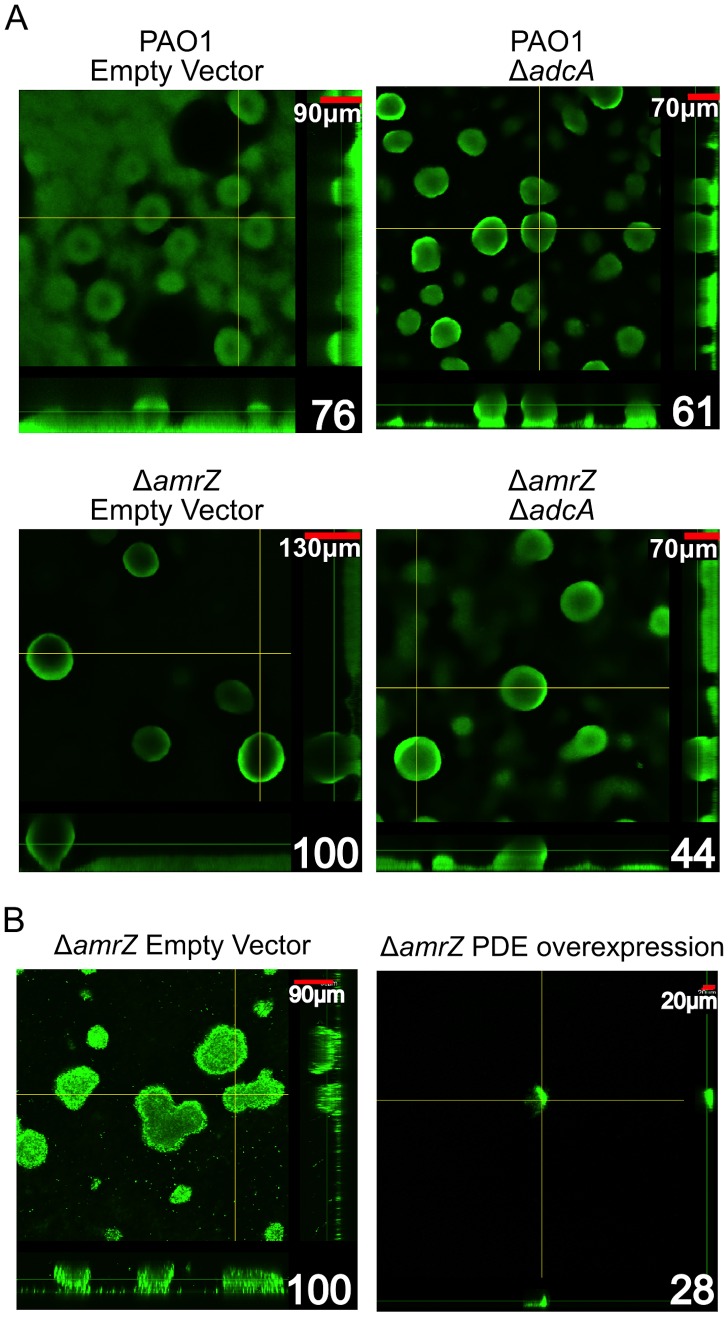
The ΔamrZ mutant strain hyper biofilm phenotype is adcA dependent.A. Biofilm biomass and microcolony height correlate with adcA expression. Orthogonal confocal laser scanning microscopy images of 24-hour flow cell biofilms are shown with Syto-9 stained biomass depicted as green. Scale bars are in the upper right corner of each image and percent biomass (determined via COMSTAT analysis) relative to the ΔamrZ empty vector are indicated in the lower right corner. Significance was determined with Student's t-test. (* p≤0.05). B Expression of a phosphodiesterase abrogates the ΔamrZ biofilm phenotype. Orthogonal confocal laser scanning microscopy images of 16-hour flow cell biofilms are shown with Syto-9 stained biomass depicted as green. Scale bars are in the upper right corner of each image and percent biomass (determined via COMSTAT analysis) relative to the ΔamrZ empty vector are indicated in the lower right corner. Biofilms were initiated and grown in the presence of 0.5% arabinose to induce expression of the phosphodiesterase PA2133 from the plasmid pJN2133. Significance determined with Student's t-test. (* p≤0.05)